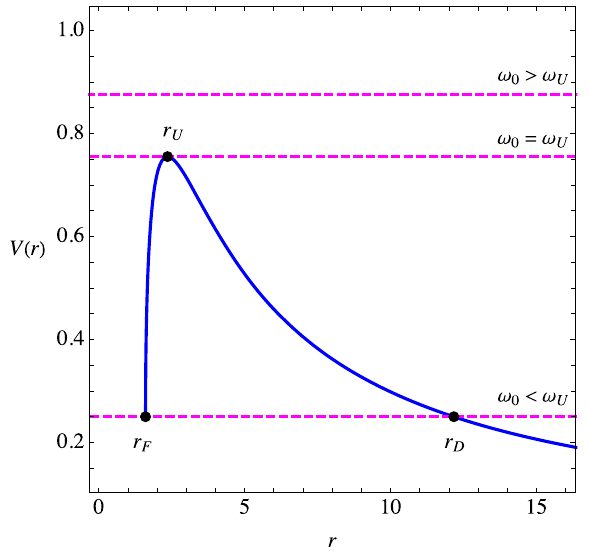
Fig. 2 A typical effective potential, plotted for a = 0 . 8 M , L = 1 M , and Q + f r = 10 M 2 (whicharethevaluesthatwillbetakenintoaccount for all the forthcoming diagrams in this paper). The categorization of orbits is done by comparing the photon energy ω 0 with that for photons on the UCO, i.e. ω U (for the above values, ω U ≈ 0 . 755232).